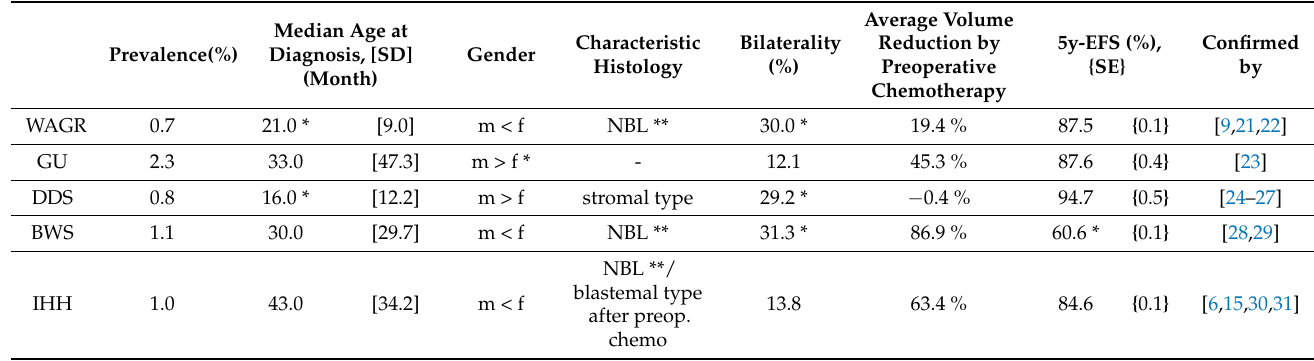
Table 6. Summary of results in the top 5 syndromes associated with WT. * significant results ( p < 0.05); ** isolated nephroblastomatosis, Standard deviation (SD), Standard error (SE). BWS: Beckwith-Wiedemann spectrum; IHH: isolated hemihypertrophy; DDS: Denys-Drash syndrome; WAGR: Wilms tumor, aniridia, genitourinary abnormalities, range of developmental